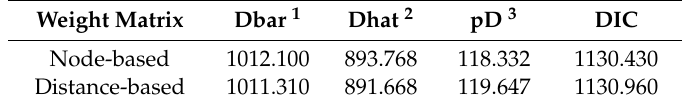
Table 2. The results of the proposed method using two kinds of spatial matrices.